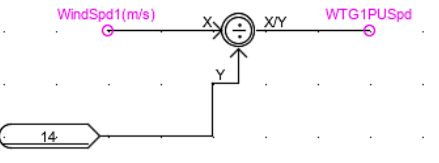
Figure 19. The logic for wind turbine generator per - unit speed control.